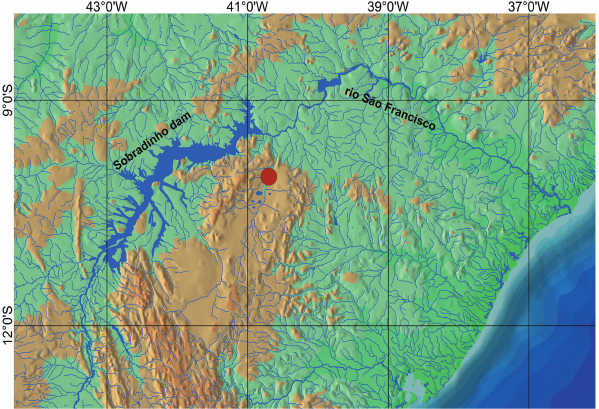
Fig. 4. Known distribution of Phenacogaster julliae . Red dot represents the type